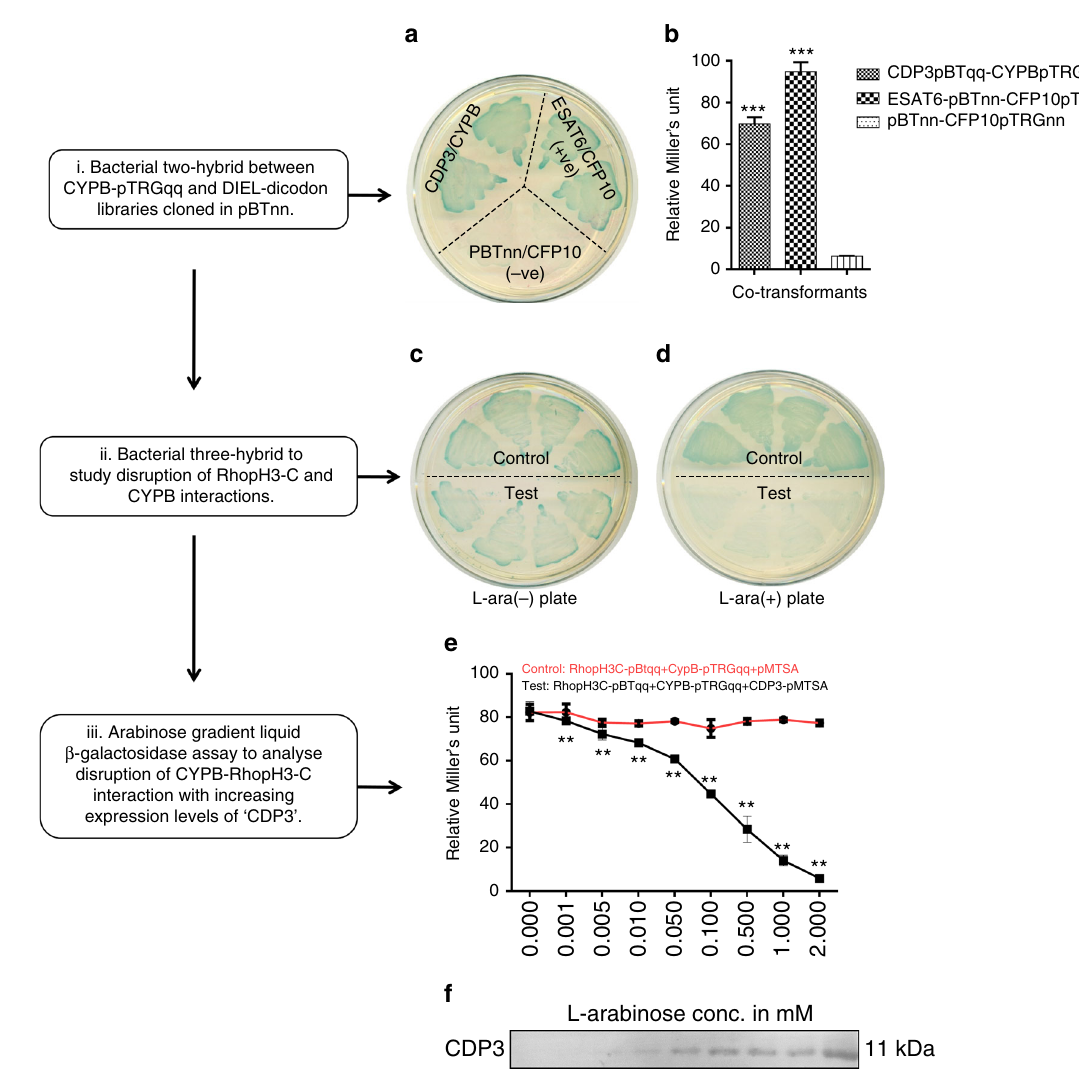
Fig. 5 Identi fi cation of a de novo peptide that binds Cyclophilin B. a Bacterial two-hybrid assay to identify de novo interacting partner against CYPB from dicodon library. Streaks of bacterial two-hybrid experiments between DIEL-pBTnn and CYPBpTRGqq on X-gal indicator plate. All streaks are labeled to represent genes cloned in pBTnn and pTRGnn. CFP10pTRGnn/Emptyp BTnn and CFP10pTRGnn/ESAT6pBTnn signify the negative and positive controls, respectively. b Liquid β -galactosidase assay to estimate the relative enzymatic activity in Miller ’ s unit (M.U.) of the interaction between identi fi ed de novo dicodon library interacting partner (CDP3) and CYPB. The graph is the average of three independent assays with error bars representing the standard deviation. All values were tested for signi fi cance using a two-tailed unpaired Student ’ s t -test with Welch ’ s correction. *** P < 0.001. c , d Bacterial three- hybrid assay to monitor the disruption of PfRhopH3-C/CypB interaction by CDP3 in vivo. X-Gal indicator plate without L -arabinose and X-gal indicator plate with L -arabinose. Test streaks: Triple co-transformants containing PfRhopH3CpBTqq, CYPBpTRGqq, and CDP3pMTSA; control streaks: triple co- transformants containing PfRhopH3-CpBTqq, CYPBpTRGqq, and empty pMTSA. e L -arabinose gradient liquid β -galactosidase assay. Relative β -galactosidase activity Miller ’ s unit (M.U.) of the triple co-transformants containing PfRhopH3-CpBTqq, CYPBpTRGqq and empty pMTSA (red line, control) and triple co-transformants containing PfRhopH3CpBTqq, CYPBpTRGqq, and CDP3pMTSA (black line, test), is plotted against a range of L -arabinose concentrations. The graph is the average of three independent assays and the standard deviation is represented as the error bars. Multiple unpaired t -tests to compare enzyme activity of each triple co-transformant across individual L -arabinose concentrations were used. Statistical signi fi cance was determined using the unpaired t -test with Welch ’ s correction. ** P < 0.01 was considered signi fi cant. f Western blot of triple co-transformants R1 E. coli whole-cell lysates shown in e , in order to analyze the concomitant expression of CDP3 protein with increasing concentrations of L screened a dicodon polypeptide synthetic library 22, 33, 34 to named CDP3 (Supplementary Table 5, Supplementary Fig. 7a) identify potential de novo peptide/proteins binders to Cyclophilin was identi fi ed as an interactor of Cyclophilin B after several B. A bacterial two-hybrid screening was performed between the rounds of segregation, re-cloning and re-transformations. We Cyclophilin B gene cloned in pTRGqq plasmid, referred as have earlier used a similar approach to identify the role of host CYPBpTRGqq, and a de novo dicodon polypeptide synthetic ICAMs in cell invasion by M. tuberculosis and P. falciparum 22 . To library cloned in pBTnn plasmid referred as DIEL-pBTnn (Sup- further explore the interaction between CDP3 and Cyclophilin B, plementary Fig 7g). CFP10pTRGnn/empty pBTnn and we cloned and expressed CDP3 in pMTSA plasmid. C-terminal CFP10pTRGnn/ESAT6pBTnn served as the negative and positive Histidine-tagged CDP3 was puri fi ed from E. coli BL21 (DE3) controls, respectively 22 (Fig. 5a, b). A 98 aa long de novo protein strain under denaturing conditions on Ni-NTA + column and the